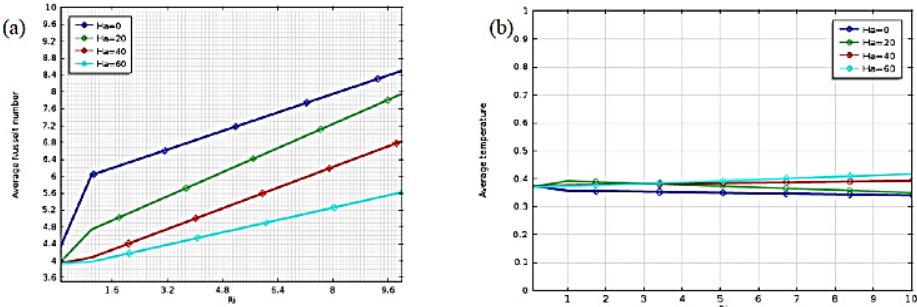
Figure 19. Effect of Hi and on ( a ) mean Nusselt number and; ( b ) mean temperature. Reprinted with permission from Ref. [40]. 2017, Elsevier.